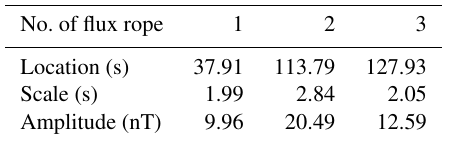
Table 1. The location, scale and amplitude of the flux ropes iden- tified by the method. The amplitude is defined as the values of the bipolar variation from minimum to